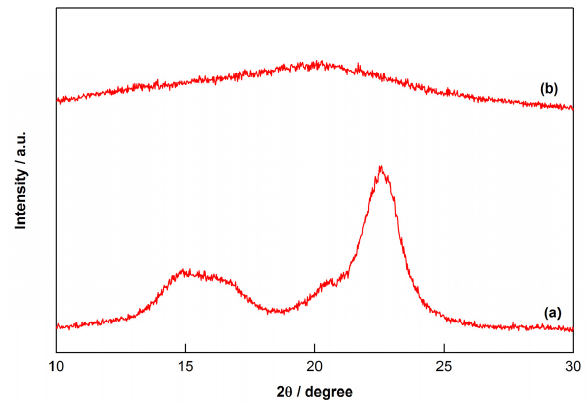
Figure 1. XRD patterns of ( a ) un ‐ milled cellulose and ( b ) milled cellulose.